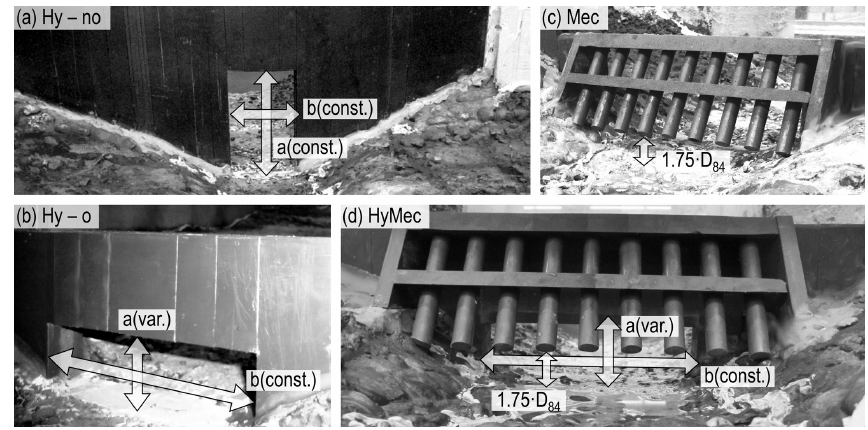
Figure 6. Tested barrier types: hydraulic deposition control only with constriction height a and width b ; (a) case Hy-no without the possi- bility of structure overflow and (b) case Hy-o, with limited barrier height (0.11m); mechanical deposition control by (c) a bar screen (case Mec) with a height of 0.11m; and (d) the combination of hydraulic and mechanical deposition control (case HyMec), with the bar screen superposed to the flow constriction with variable constriction height a and constant width b .